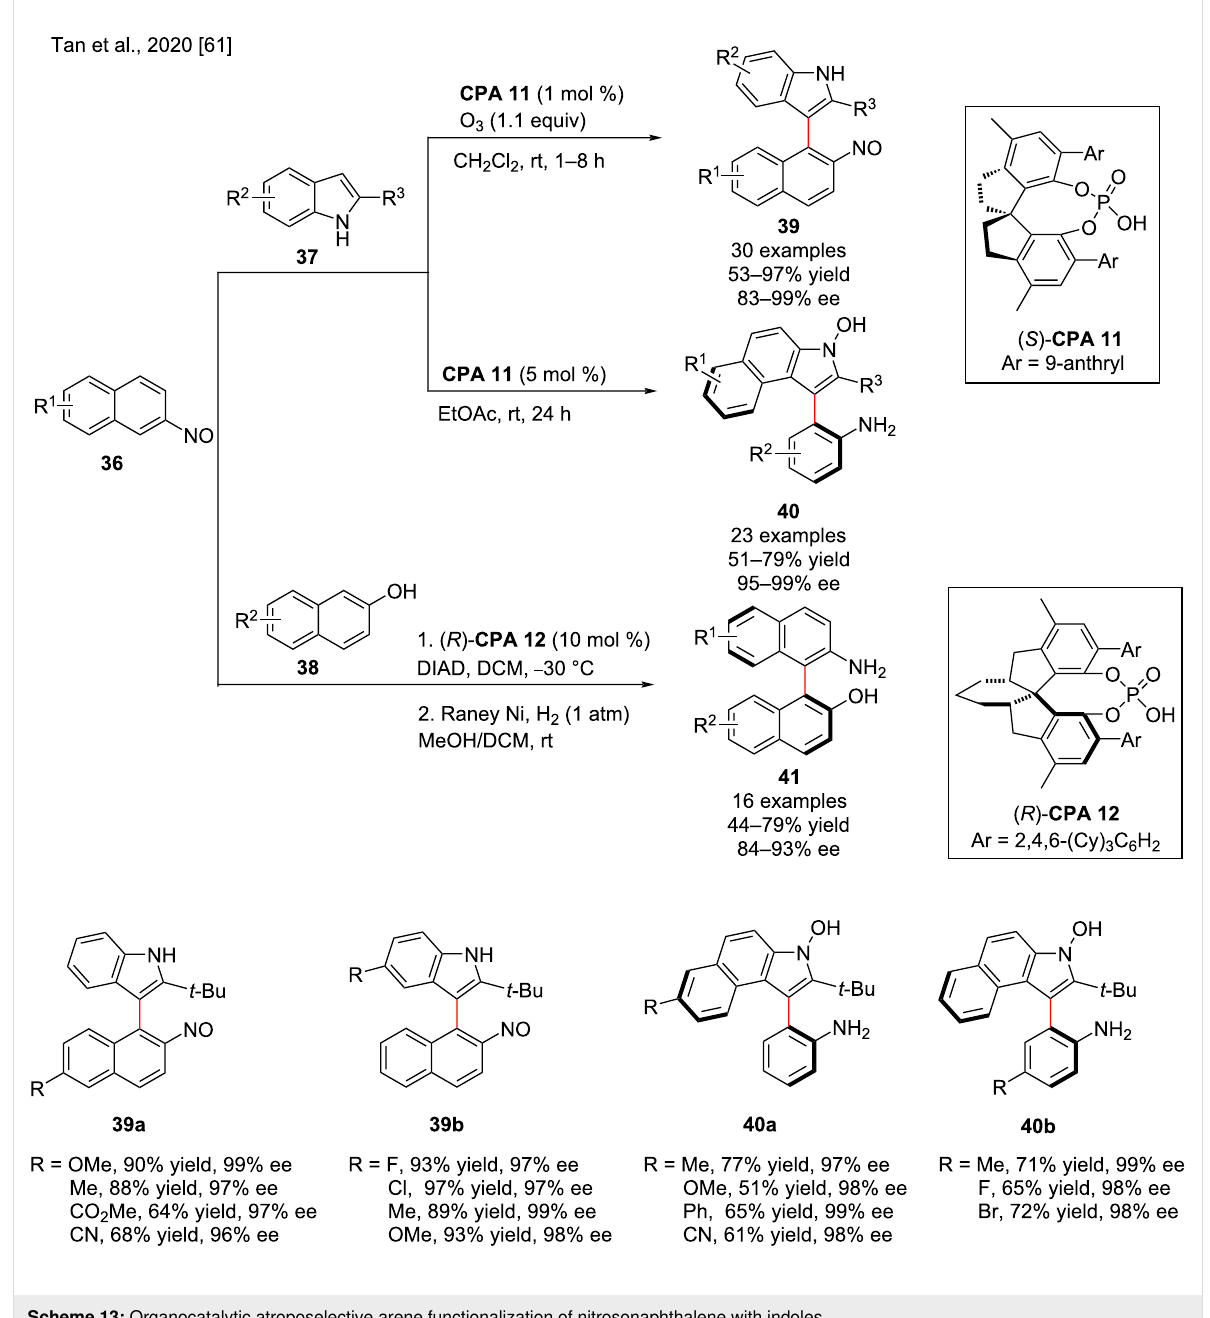
>95:5 dr, >99% ee, Scheme 16). Moreover, the introduction of a bulky group into the ortho -position of prochiral 3,3’-bisin- doles allowed the synthesis of new members of axially chiral biaryls (3,3’-bisindole derivatives) bearing both axial and central chirality in high yields and excellent stereoselectivities. Moreover, this methodology represents a new strategy for the catalytic enantioselective synthesis of axially chiral 3,3’-bisin- dole backbones from prochiral substrates